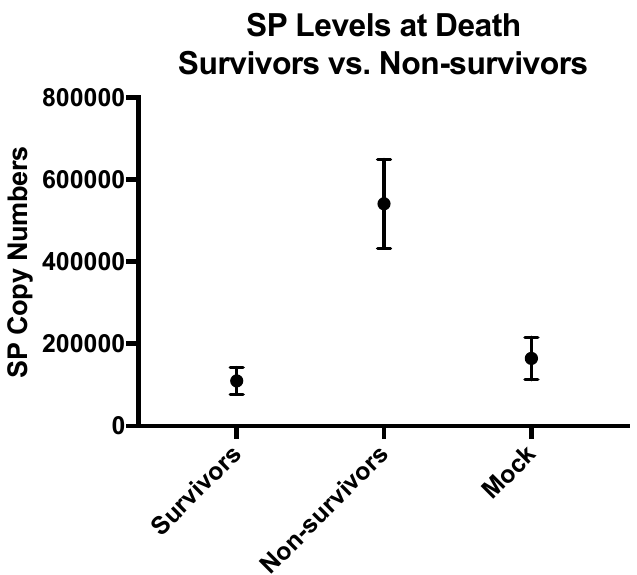
Figure 6. Comparison of SP levels between survivors, non-survivors, and mock-infected animals at time of euthanasia. Means are expressed with the standard error. SP levels correspond to the number of SP RNA copies per µ L of RNA. For these reactions, 2 µ L of RNA was